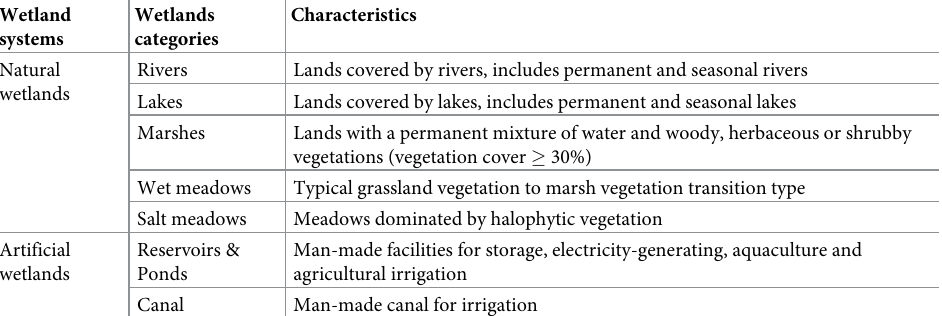
Table 1. Wetland classification system in Inner Mongolia based on remote sensing images. Wetland